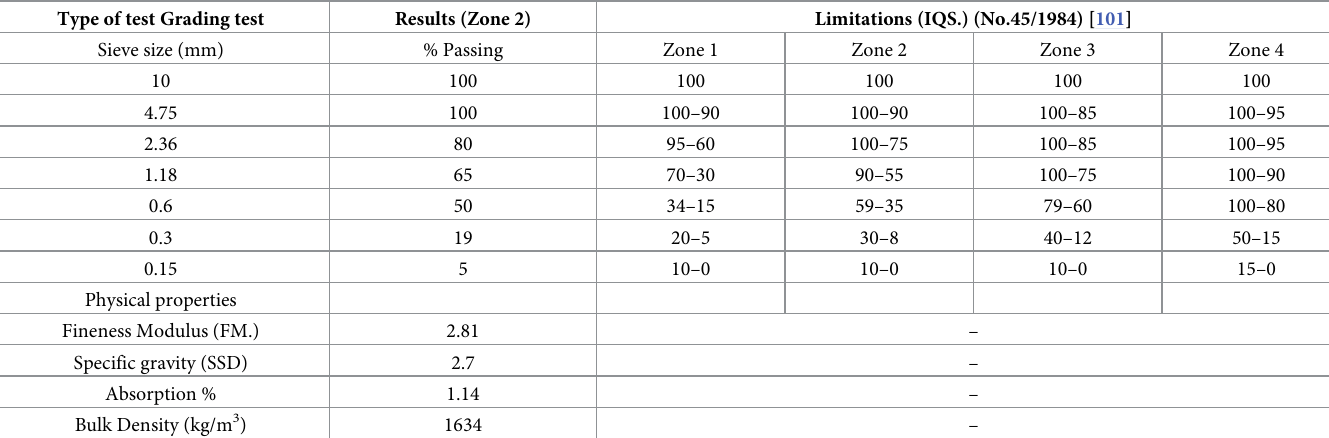
Table 3. Grading test and physical properties of fine aggregate.